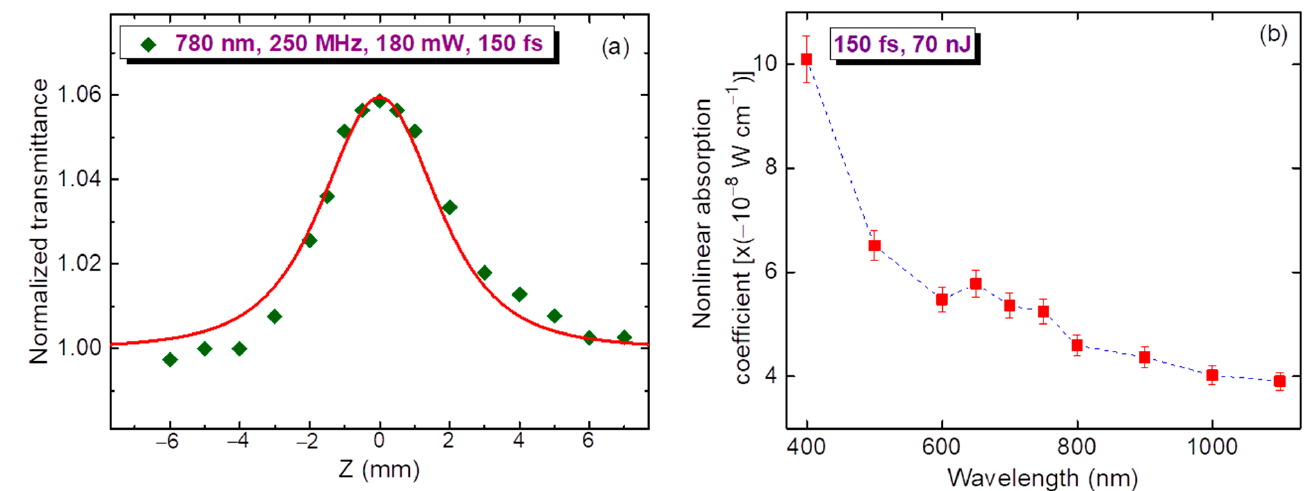
Figure 5. ( a ) OA Z-scan of MTQD film using a high-pulse rate laser (780 nm, 250 MHz, 180 mW, 150 fs). Green rhombs: experiment, solid red curve: fitting using Equation (2). ( b ) Spectral dependence of the nonlinear absorption coefficient β SA of thin film. The measurements were carried out using 150 fs, 50 nJ pulses.